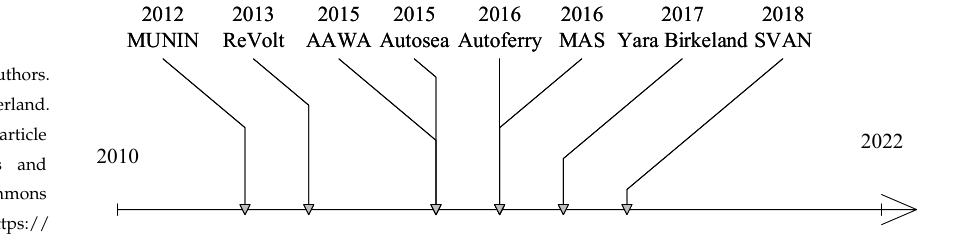
Figure 1. A timeline of recent projects on autonomous